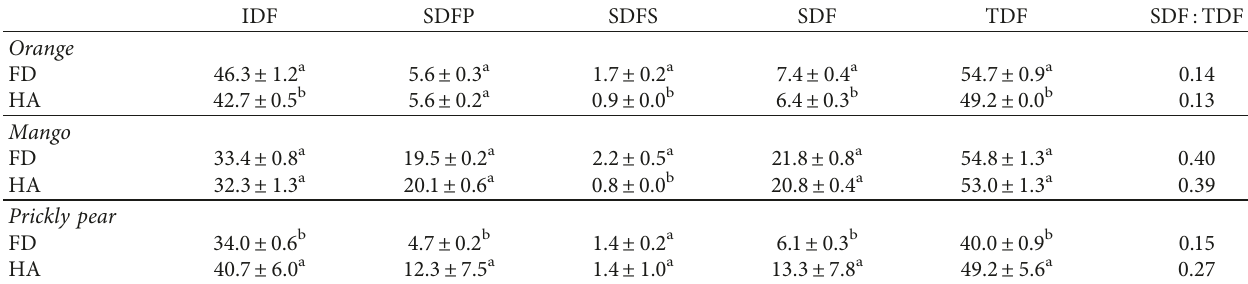
Values are mean of three determinations ± SD. Values per fruit (freeze-dried or convective hot air-dried) within the same row followed by different letters are significantly different ( p < 0 . 05). ∗ Carbohydrate content includes digestible and nondigestible carbohydrates (i.e., dietary fibre) and was calculated by difference. Table 3: Dietary fibre composition (g · 100g − 1 db) of dietary fibre concentrates from orange, mango, and prickly pear peels freeze-dried (FD) and convective hot air-dried